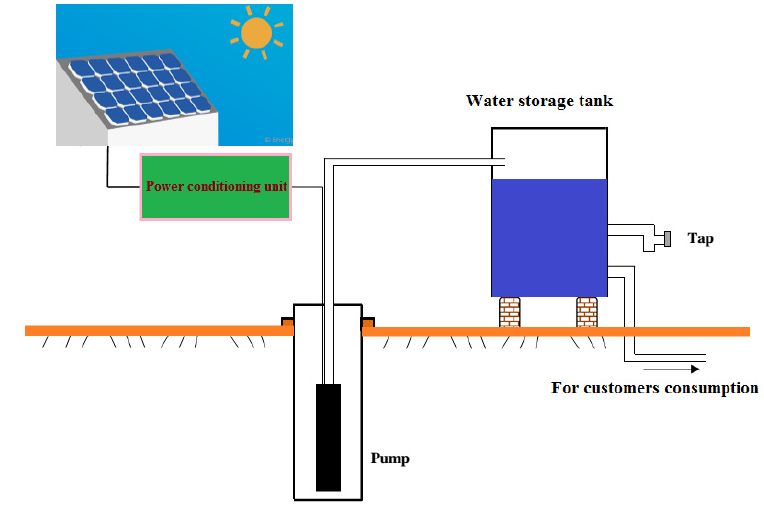
Figure 1. Schematic of the PV water-pumping system.